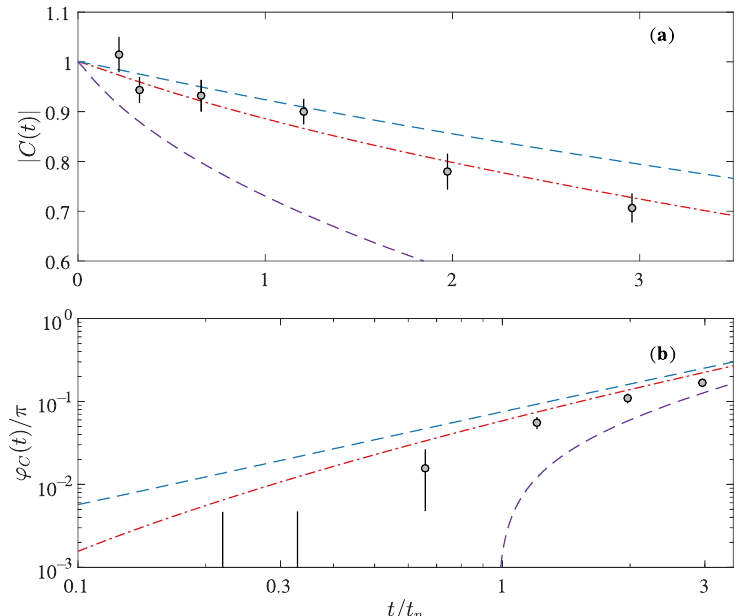
Figure 3. Transition from universal to weak coupling dynamics. ( a ) The coherence amplitude and ( b ) phase evolution at 1/ k n a = − 1.3 (circles) with Equation (1) as a dash-dotted line for its fitted value t a = 0.2 t n (red) and as dashed lines using two additional values 0.05 t n (purple) and 0.5 t n (blue). The errors correspond to fit